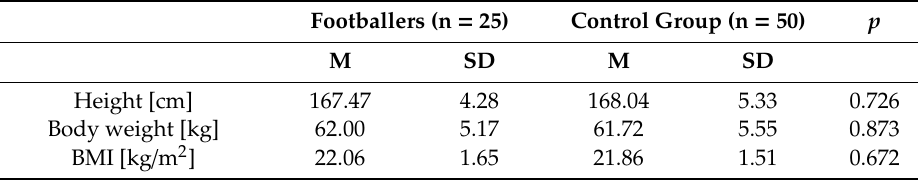
Table 1. Characteristics of female footballers and the control